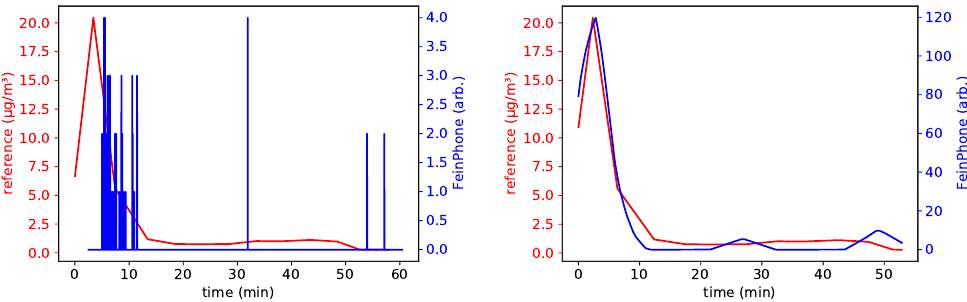
Figure 11. Results from the unventilated sensor ( B003 ). In our lab experiments, it did not make a notable difference whether the sensor was ventilated or not (cmp. data of sensor B001 in Figure 8 respectively Figure